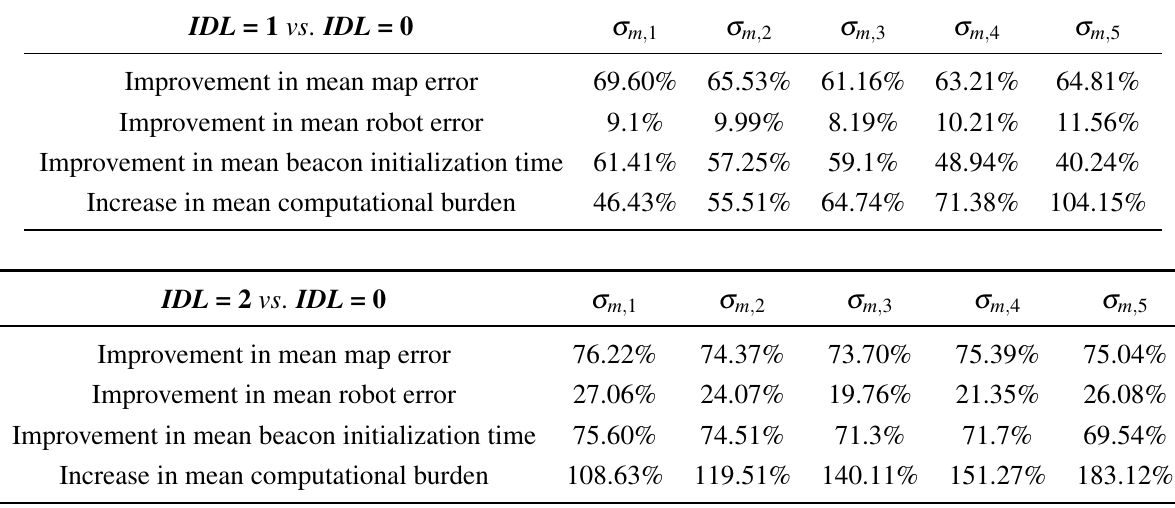
Table 1. SLAM performance evaluation between IDL = 1 and IDL = 0 ( top ) and between IDL = 2 and IDL = 0 ( bottom